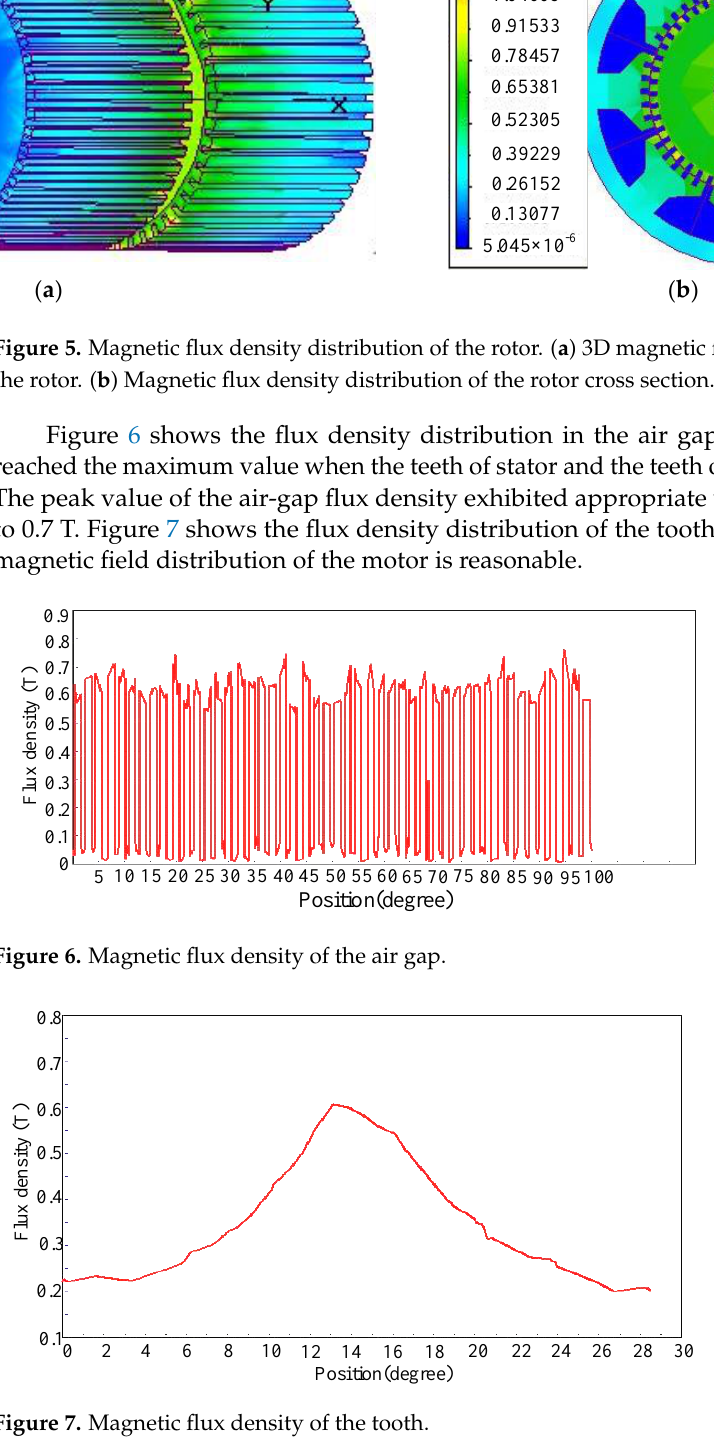
Figure 7. Magnetic flux density of the tooth. Speed parameters were added to the motor magnet for dynamic analysis of the mag- netic flux density distribution at different speeds of the motor working in dual-channel mode, as is shown as Figure 8. It can be seen from the simulation results that the magnetic density of the tooth was high. When two redundant windings were both excited, the mag- netic density distribution of the main part of the motor was not large, which is acceptable. At different speeds, the distribution of electromagnetic field in the motor is reasonable.